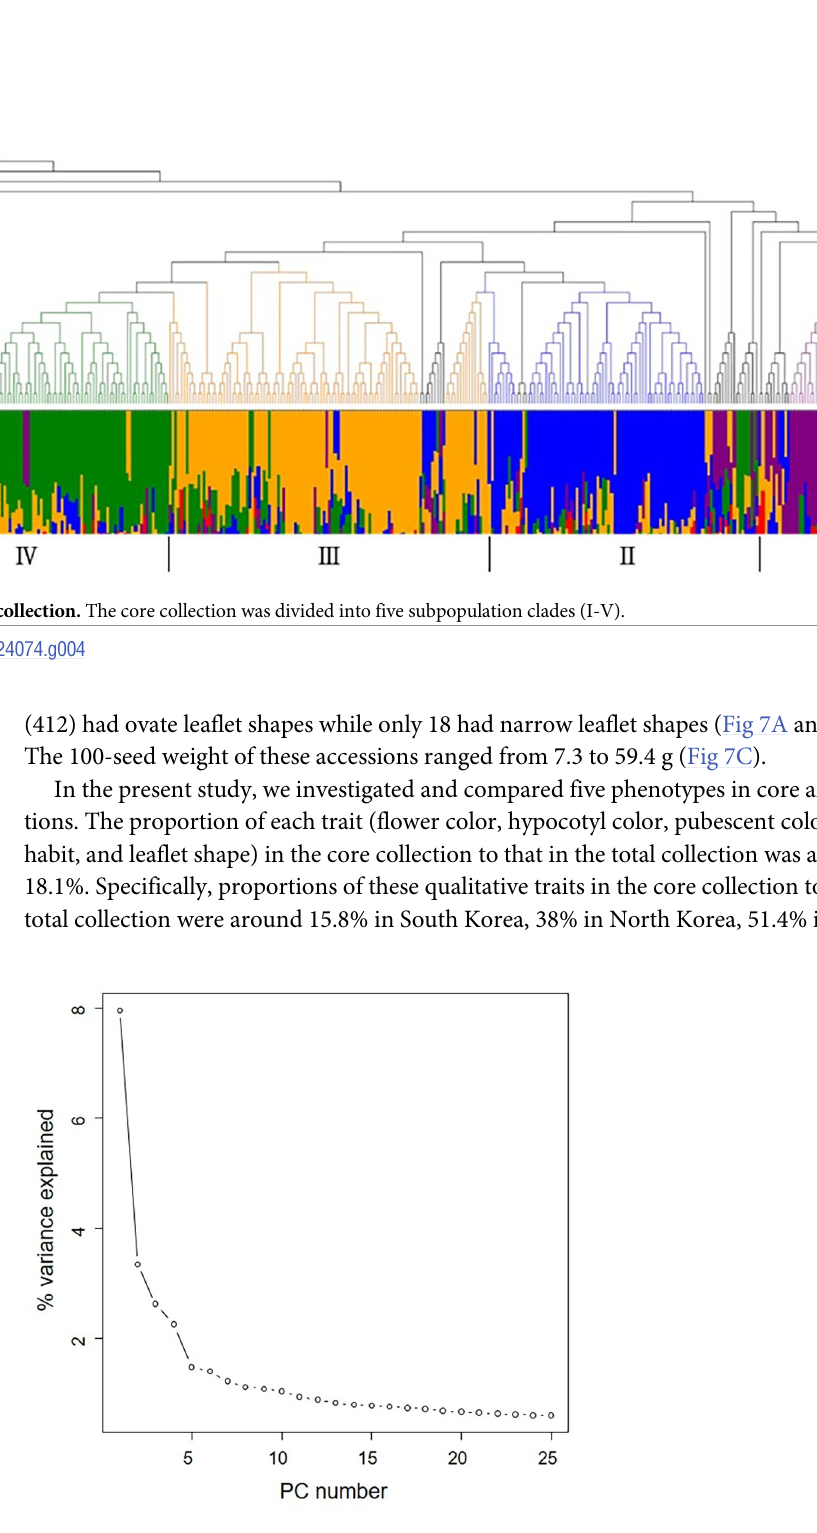
Fig 5. Scree plot of principal component analysis in the core collection between variance and number of principal components.